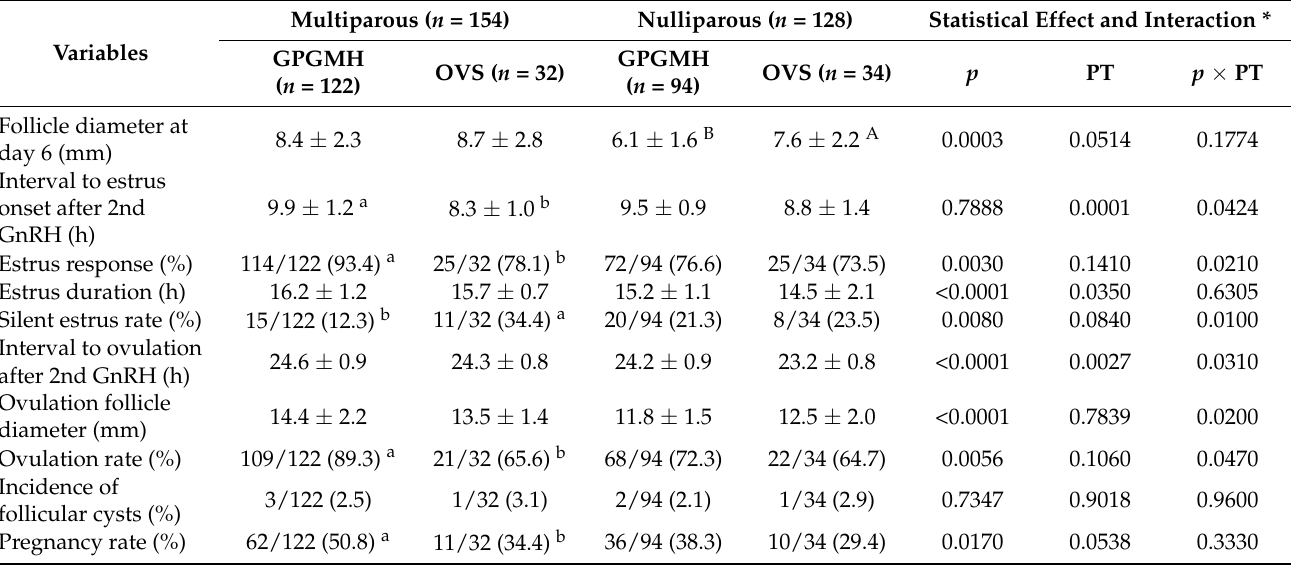
Table 2. The follicular dynamics, estrus, ovulation, and pregnancy in nulliparous and